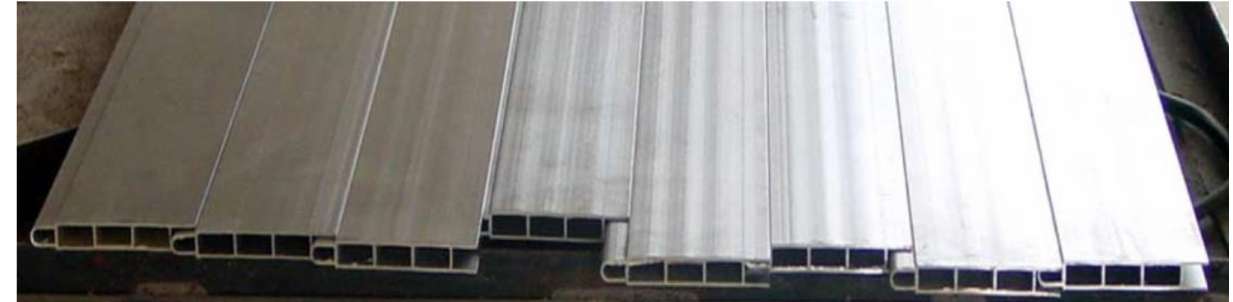
Figure 8. Assembly of aluminium finned flow channels (reprinted from [75], with permission from publisher).